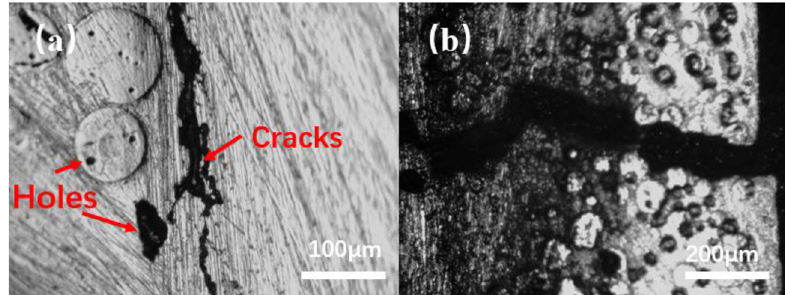
Figure 6: Surface ( a ) and cross section ( b ) defects of Ni + 30% WC sample coating in the 3.5 wt% NaCl solution.